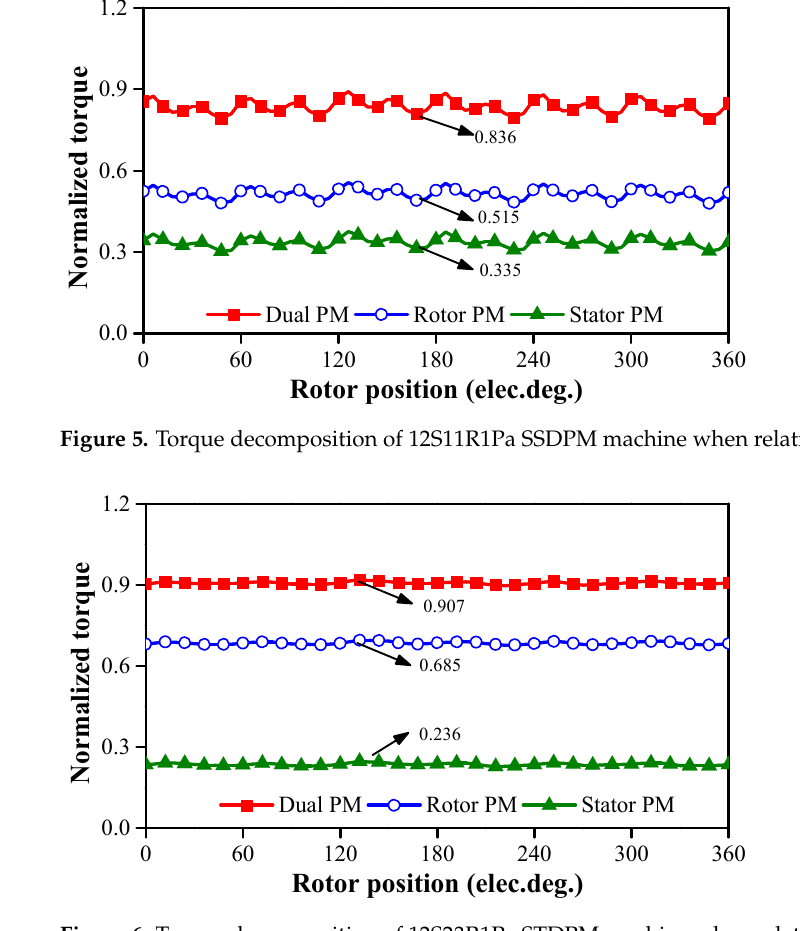
Figure 6. Torque decomposition of 12S23R1Pa STDPM machine when relative permeability is 50.